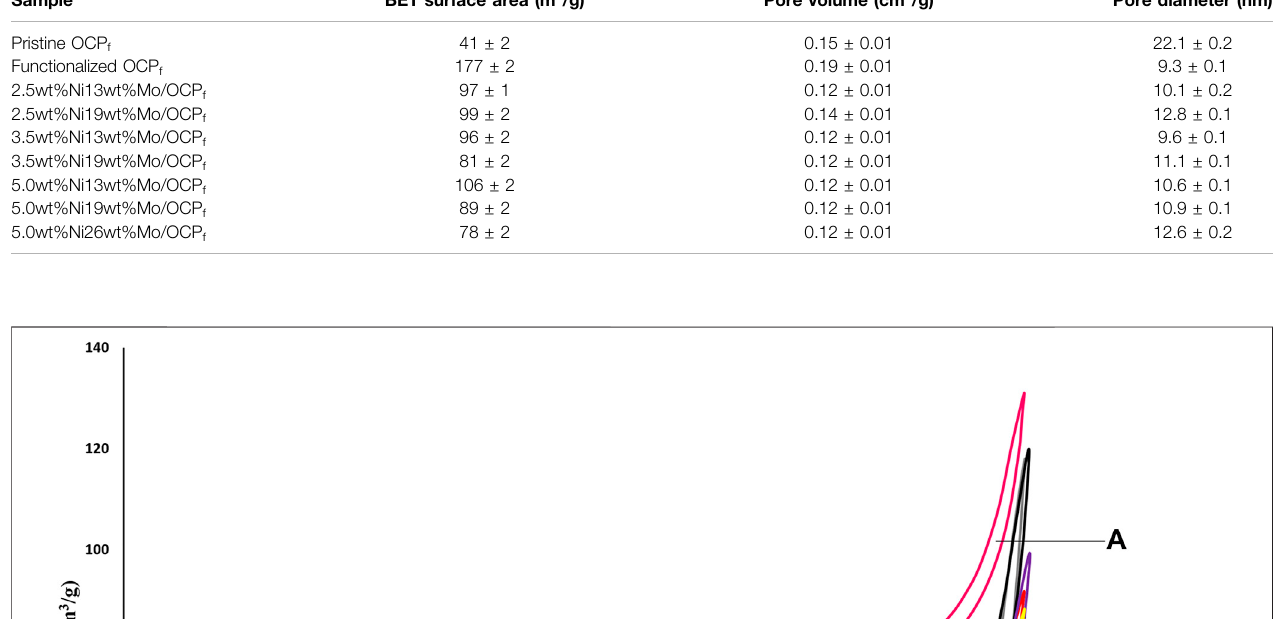
Frontiers in Chemical Engineering |